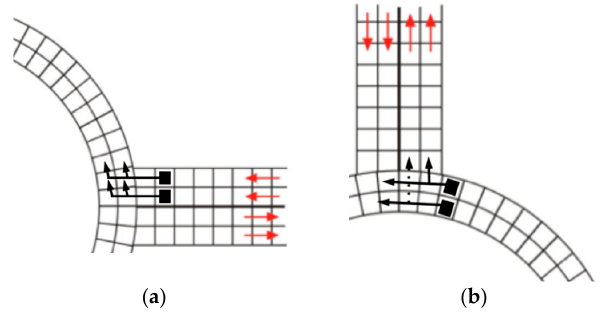
Figure 4. Scenario 3: possible directions of vehicle movement in the roundabout ( a ) enter; ( b ) exit.